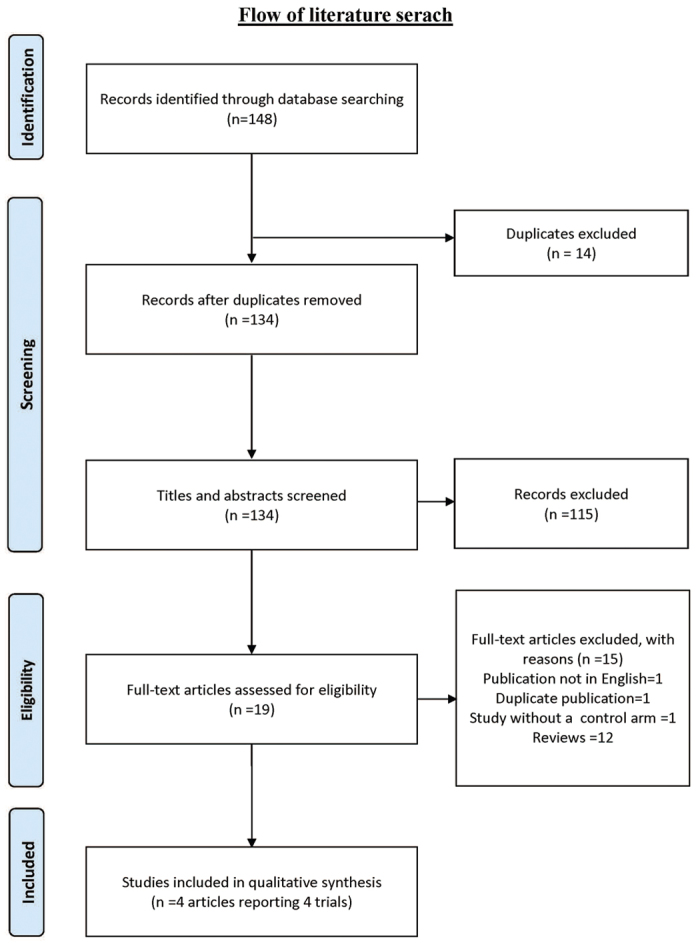
Flow of literature search.